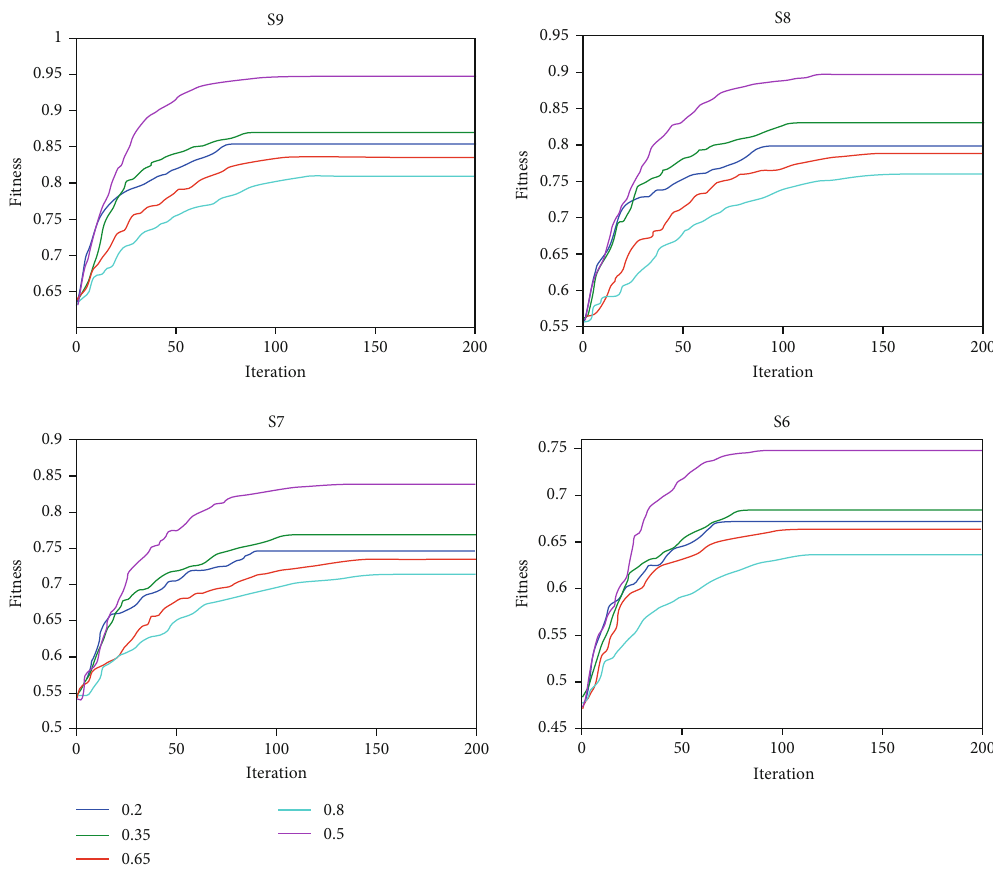
Figure 10: The fi tness curves of di ff erent crossover probabilities. Table 5: Best values and iterations of di ff erent crossover